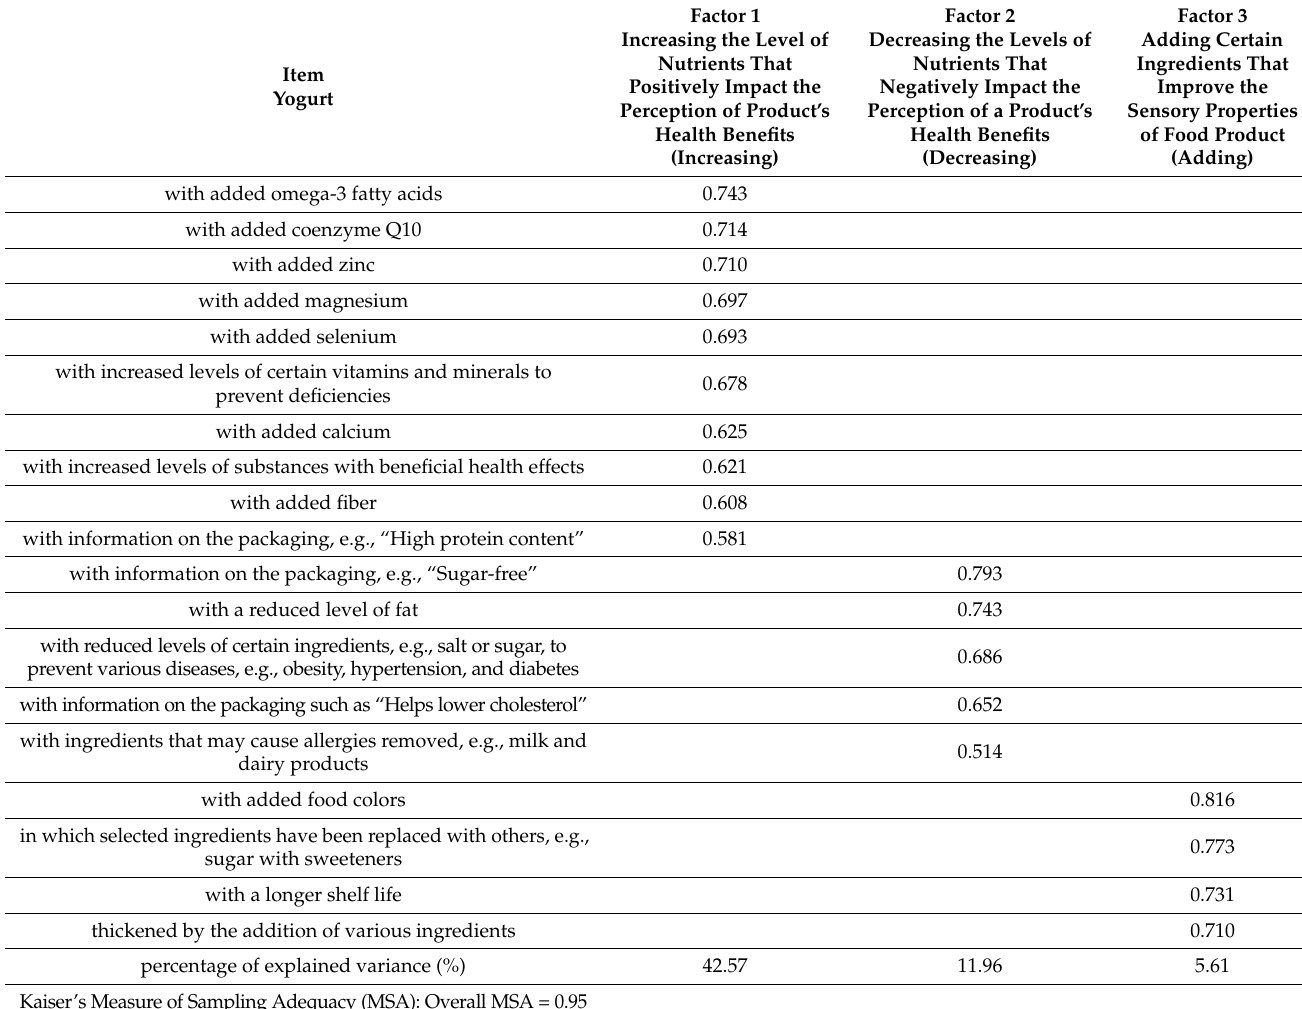
Table 1. Principal component analysis (PCA) of interest in purchasing the following types of